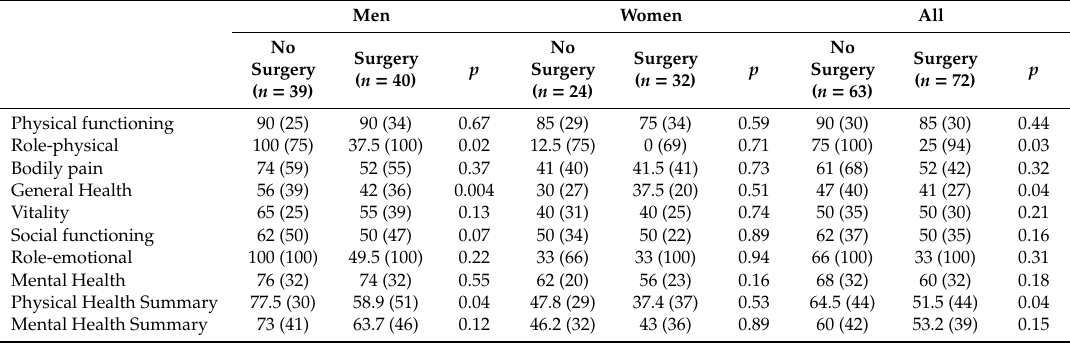
No Surgery p Surgery ( n = 72) ( n = 63)